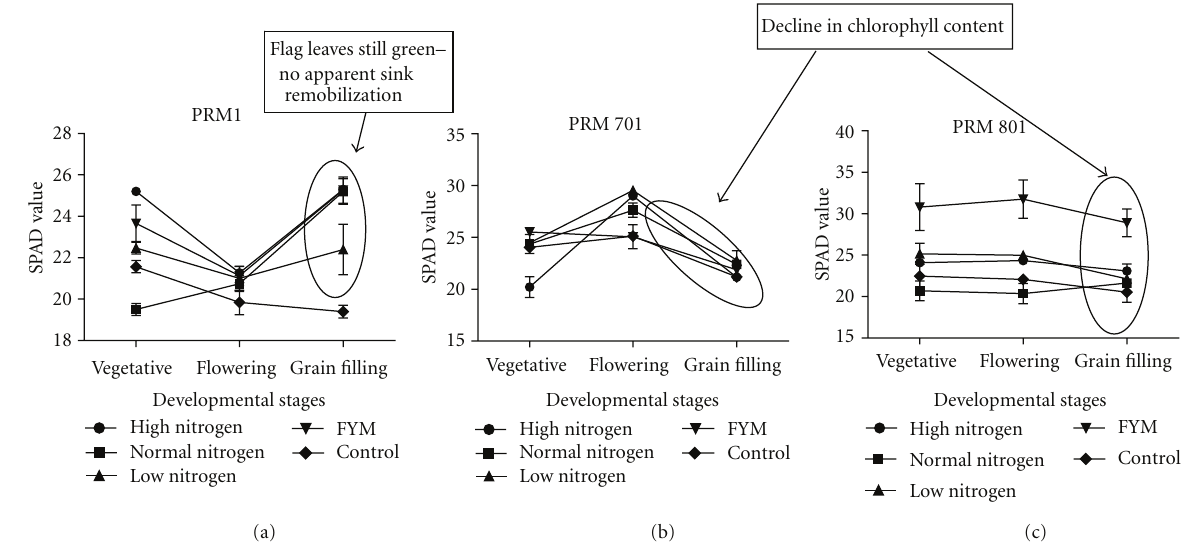
Figure 1: Influence of nitrogen fertilization on SPAD value at various developmental stages of finger millet genotypes (a) brown PRM-1, (b) golden PRM-701, (c) white